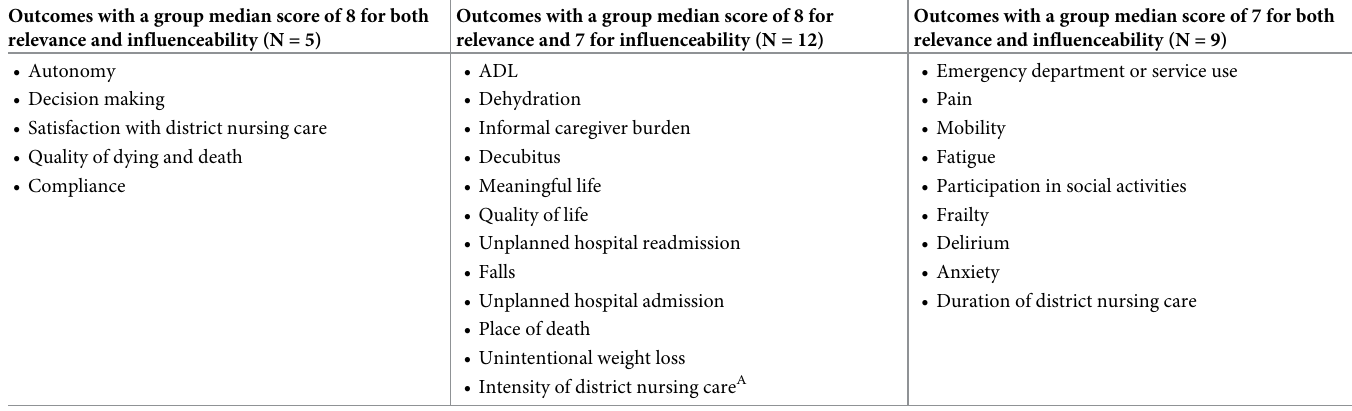
Table 3. Nurse-sensitive outcomes according to district nursing care experts. Outcomes with a group median score of 8 for both relevance and influenceability (N =